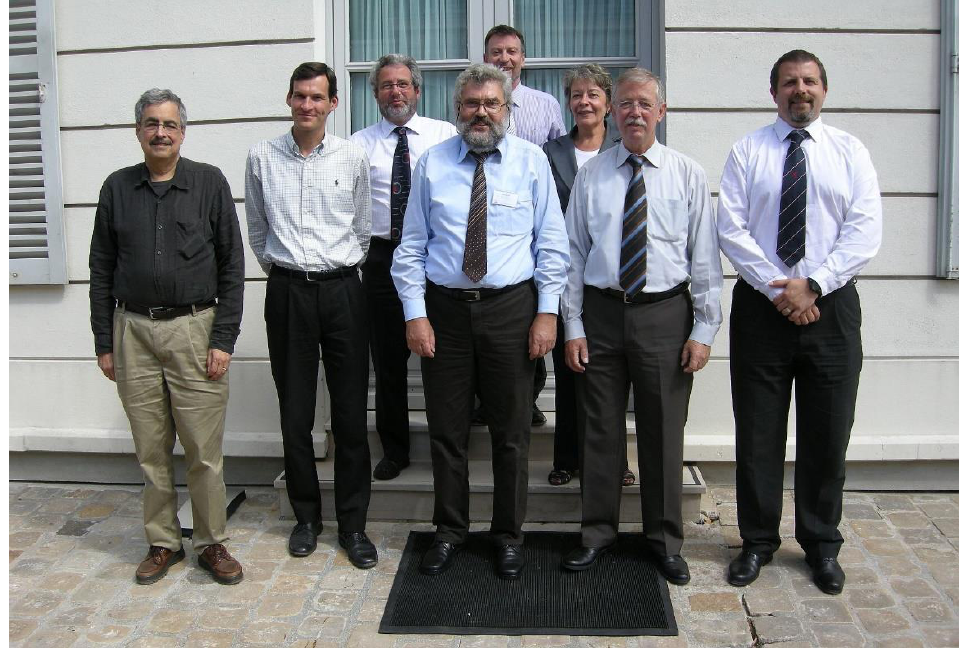
Figure 9. Initial meeting of the cooperation between BIPM and IAPWS at the Pavillon de Breteuil, Sèvres, 30 August 2011. From left to right: Richard Davis, Michael Stock, Alain Picard † , Rainer Feistel, Andy Henson, Claudine Thomas, Michael Kühne, Robert